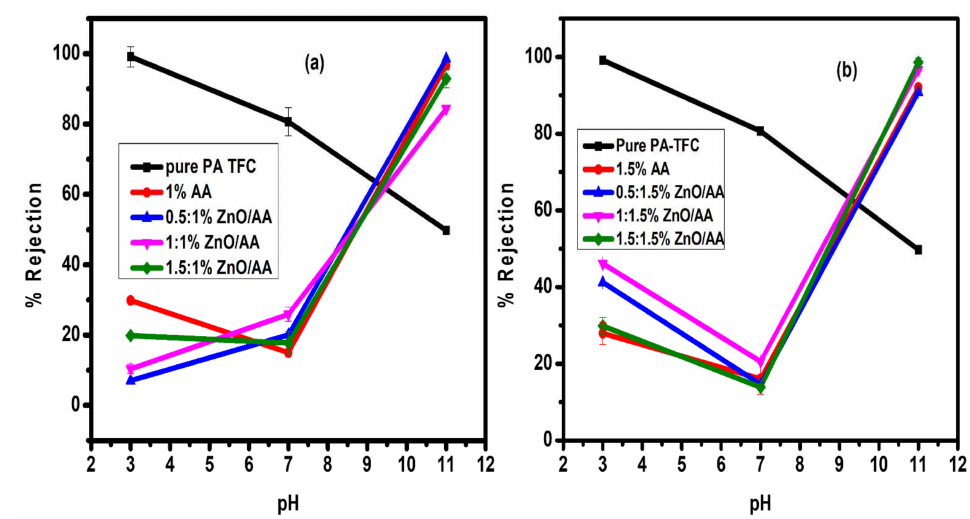
Figure 10. The Pb (II) ions rejection (%) of: ( a ) membranes modified with 0.00% AA, 1.00% AA, 0.50:1.00% ZnO/AA, 1.00:1.00% ZnO/AA, and 1.50:1.00% ZnO/AA; and: ( b ) membranes modifies with 1.50% AA, 0.50:1.50% ZnO/AA, 1.00:1.50% ZnO/AA, and 1.50:1.50% ZnO/AA as a function of